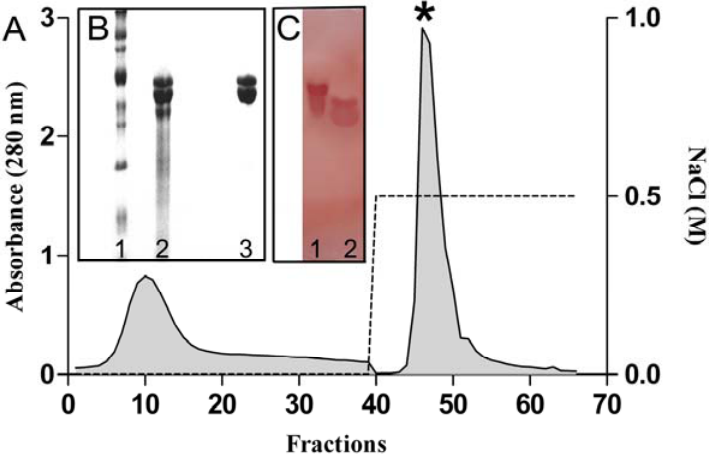
Figure 1. ( A ) Elution profile of the lectin from C. fairchildiana on DEAE-Sephacel column (8 × 1.5 cm 2 ). Fractions of 2.5 mL were collected and monitored by absorbance at 280 nm. * Peak active; ( B ) SDS-polyacrylamide gel electrophoresis on 12%, lane1: molecular markers: myosin (212 kDa), β -galactosidase (116 kDa), phosphorylase B (97.4 kDa), bovine serum albumin (66.2 kDa), ovalbumin (45 kDa), carbonic anhydrase (31 kDa), trypsin inhibitor soybean (21.4 kDa), and lysozyme at (14.4 kDa), lane 2: fraction acid glutelin, lane 3: peak active; ( C ) SDS-polyacrylamide gel electrophoresis on 12% colored by periodic acid Schiff, lane 1: fetuin swine; lane 2: peak